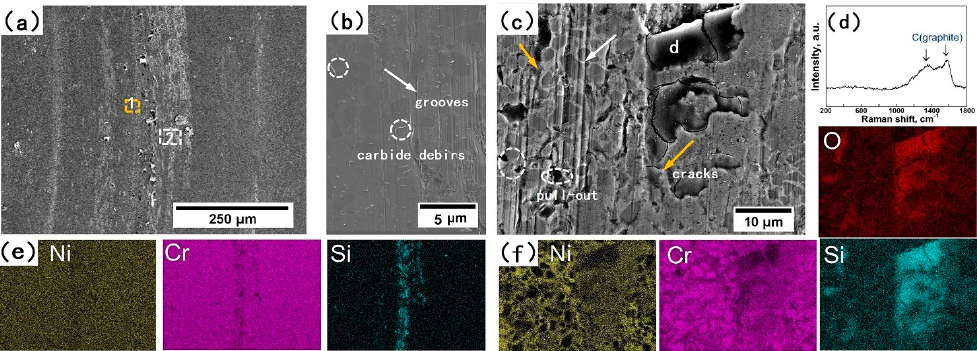
Figure 9. ( a ) Surface morphology of the wear scar of the as-sprayed coating after wear test at RT; ( b , c ), high-magnification images of the selected regions marked by 1,2 in ( a ); ( d ) Raman Spectrum of the selected area in ( c ); ( e ) EDS elemental mapping of Ni, Cr and Si of ( a ); ( f ) EDS elemental mapping of Ni, Cr, O and Si of ( c ).